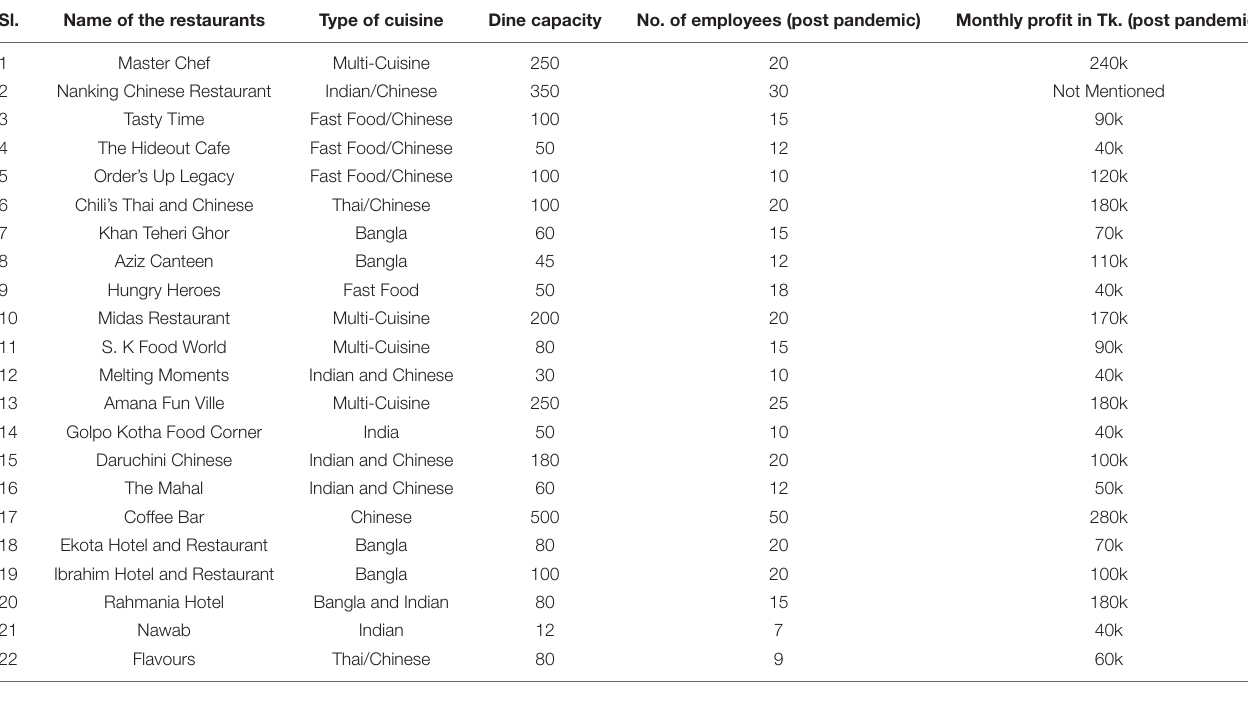
TABLE A1 | Characteristics of the restaurants.